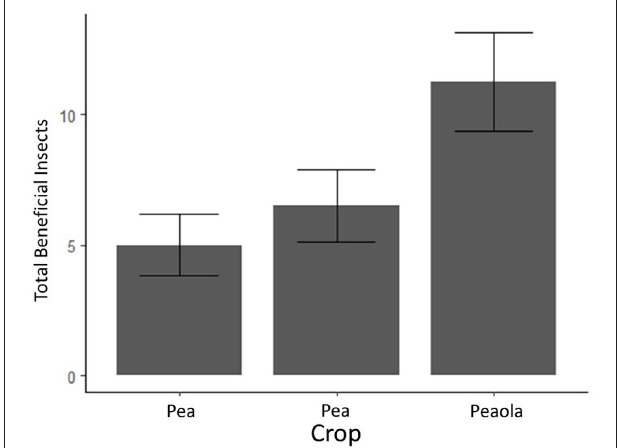
FIGURE 4 | Average counts of beneficial insects (and estimated standard errors) based on 2020 field survey. The bars with error bars that do not overlap are significantly different. Output estimates from negative binomial generalized linear mixed model.